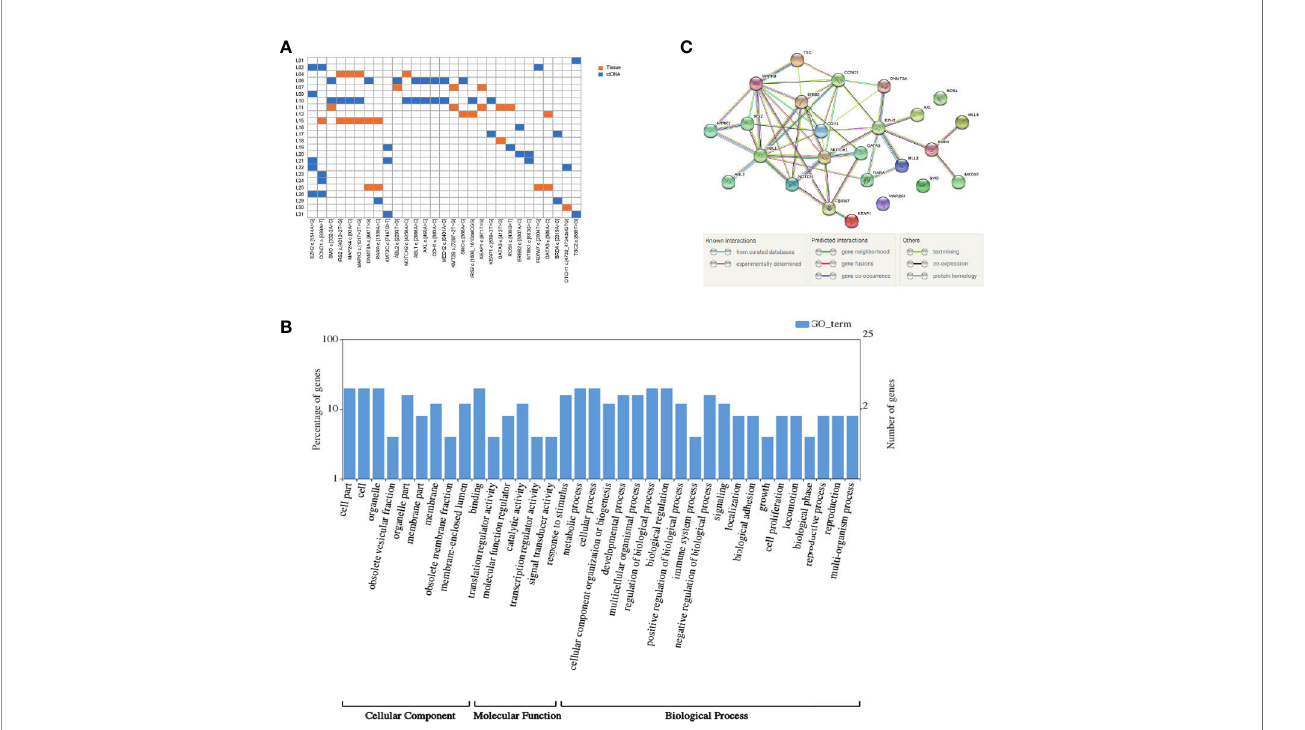
FIGURE 1 | Mutation detection and enrichment of the mutated genes. (A) The number of shared mutations found in two or more patients. Each row represents a patient, and each column represents one mutation. Blue indicates that the mutation hotspot was detected in plasma; orange indicates that the mutation was detected in the tissue. (B) GO enrichment analysis of genes in which 29 high-frequency mutations are located. (C) The PPI networks of these genes in which 29 high-frequency mutations are